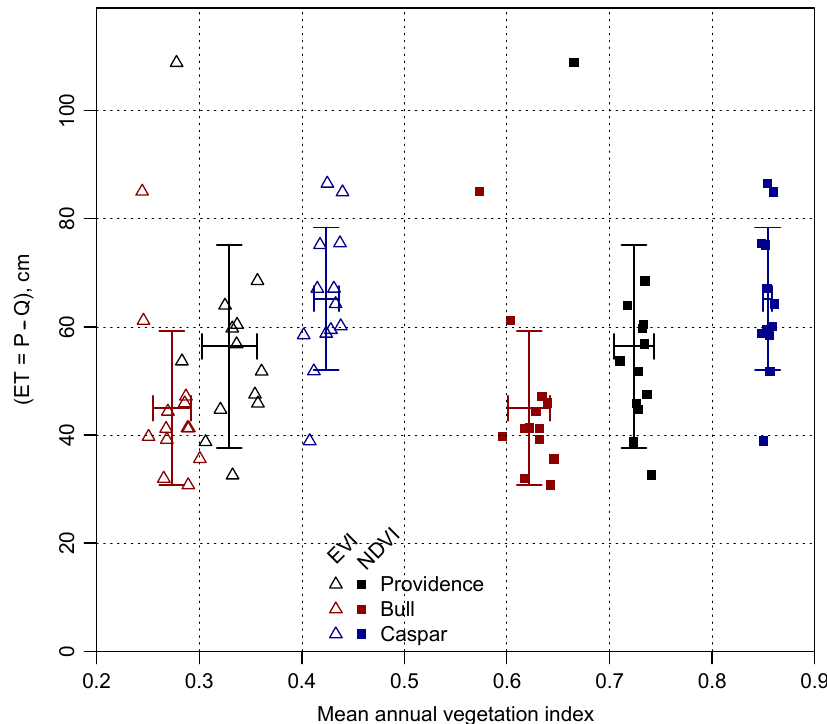
Figure 6. The mean annual vegetation index for each site compared to changes in the water balance estimate of evapotranspiration, calculated by subtracting runoff from precipitation (ET = P – Q). Lines indicate standard deviation of the enhanced vegetation index (EVI) and normalized difference vegetation index (NDVI) that cross at the mean with ET.